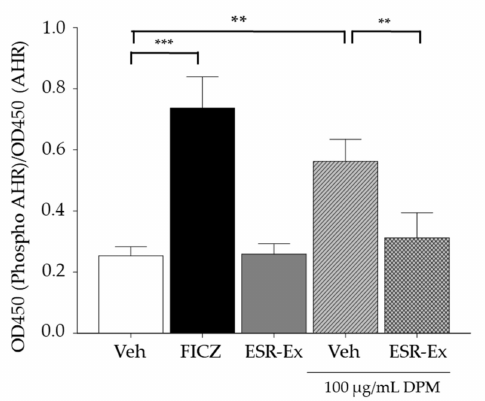
Figure 6. ESR-Ex suppresses phosphorylation of AhR in KC exposed to DPM. KC were incubated with or without FITZ (AhR ligand), ESR-Ex (100 µ g/mL) or vehicle for 30 min, and then further cultured with 100 µ g/mL of DPM for 24 h. Ratio of phosphorylated AhR to Ahr was measured by AHR Cell-Based Phosphorylation ELISA. All values are mean ± SD ( n = 3). *** p < 0.001 or ** p < 0.01 vs. indicated group. See details in Materials and Methods Section.